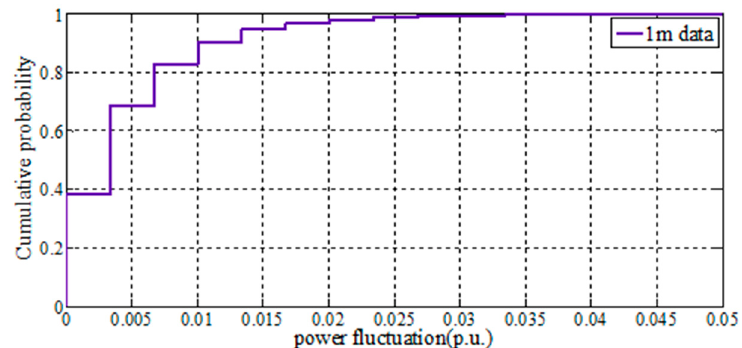
Figure 3. The cumulative probability of wind power fluctuation within 1 min.